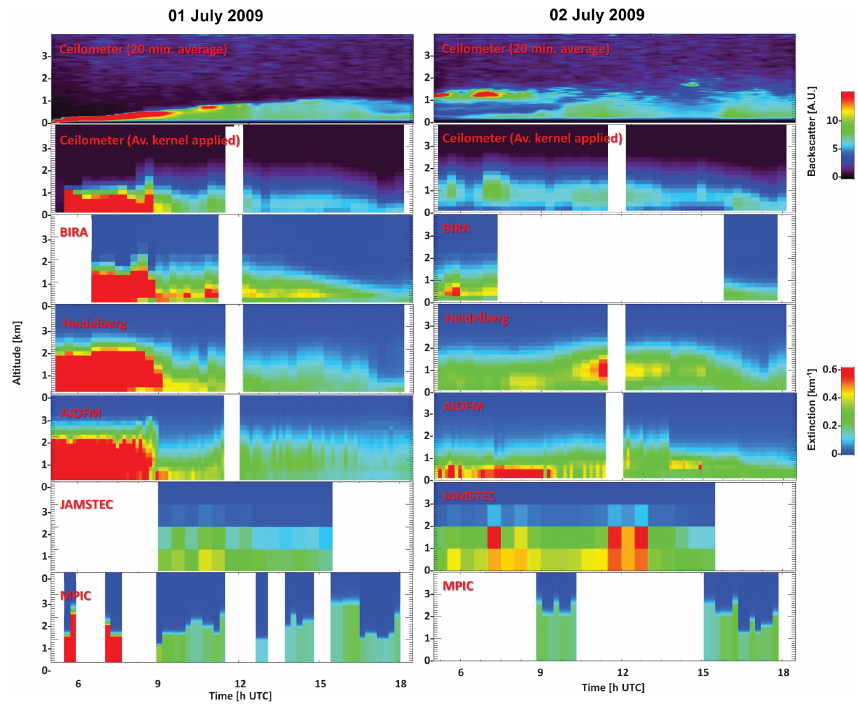
Figure 6. Same as Fig. 6 but for 1 July (left) and 2 July (right).